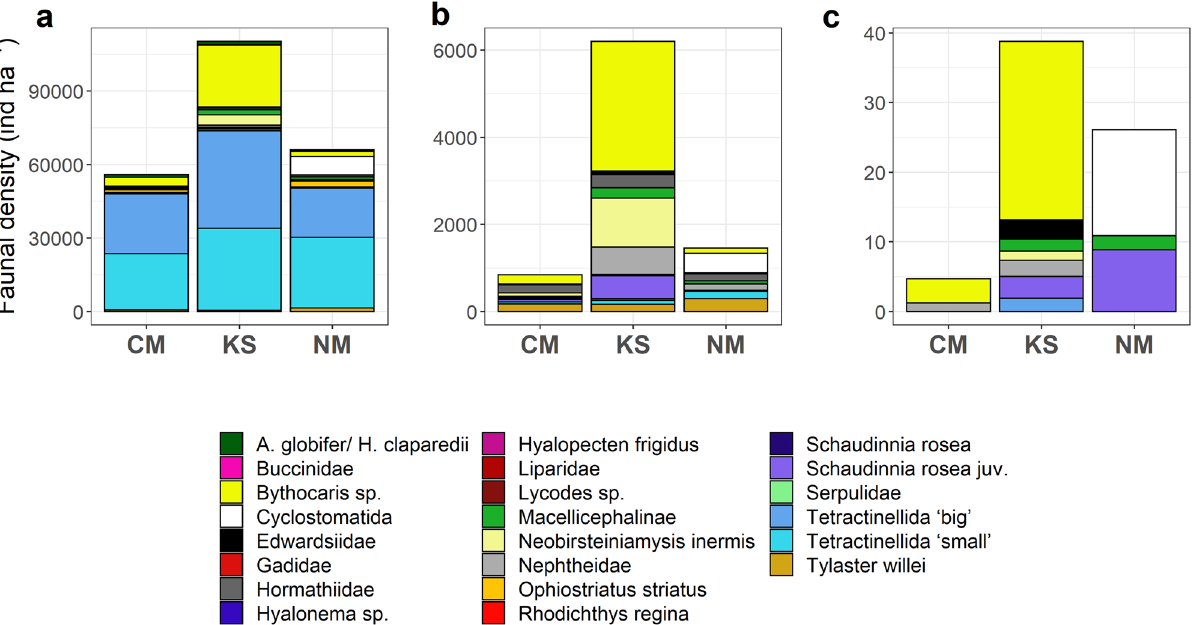
Figure 4. Invertebrate epibenthic megabenthos and fish densities at the Central Mount (CM), Karasik Seamount (KS), and Northern Mount (NM). ( a ) All fauna (ind. ha −1 ) observed at the different seamounts, ( b ) all fauna (ind. ha −1 ) that was observed being physically attached to Tetractinellida gen. indet. or walking/ crawling on top of Tetractinellida gen. indet., ( c ) all fauna (ind. ha −1 ) that was physically associated with Hexactinellida or was crawling on top of Hexactinellida.